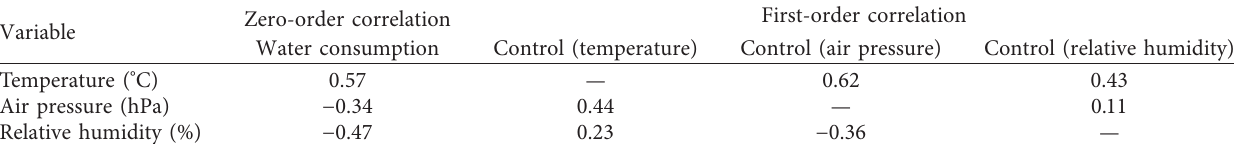
Table 1: Zero-order and first-order correlations of meteorology variables to water